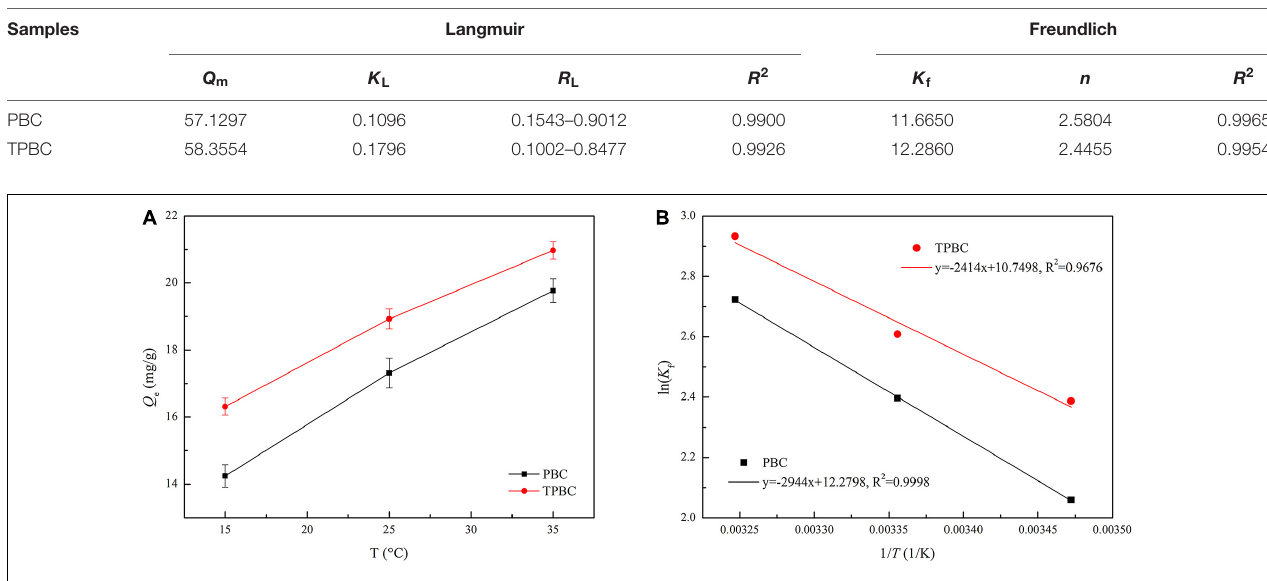
FIGURE 7 | Temperature effect on the TC adsorption by the biochars (A) and the Van’t Hoff plot for adsorption of TC on the biochars (B) .